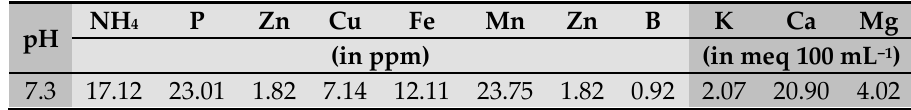
Table 1. Soil chemical properties in the study area, INIAP-EEP, 2009.